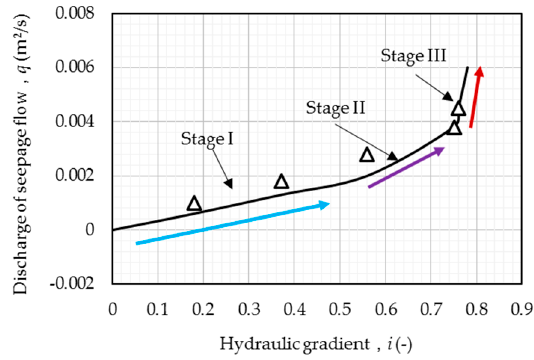
Figure 10. Three stages of suffusion process for Run 10 in Wan and Fell [1].